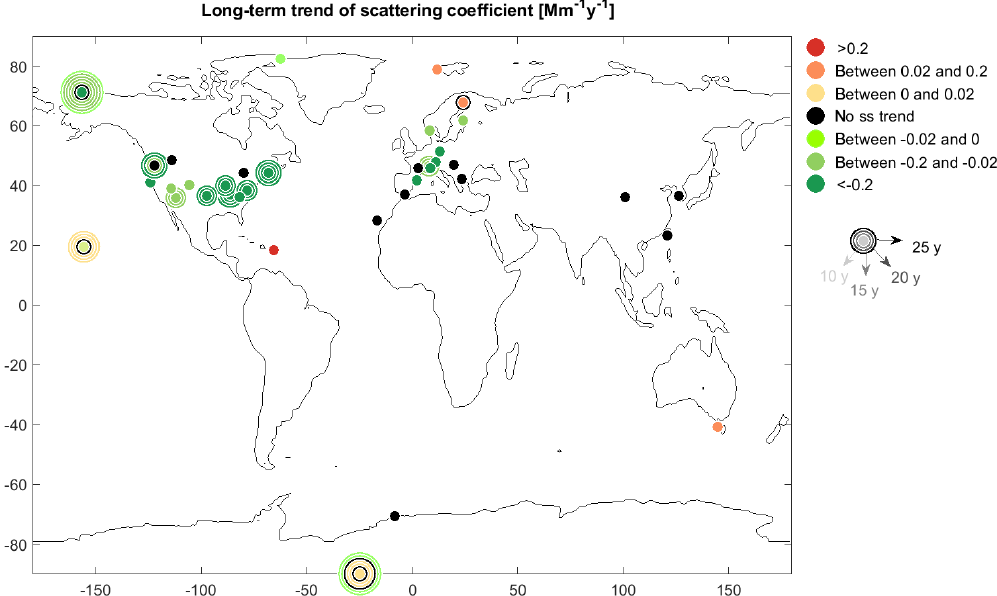
Figure 4. MK trend results for the scattering coefficient. Black symbols correspond to stations with no significant trends. Green and orange symbols correspond to ss negative and positive trends, respectively. The magnitude of the trends (slope) is given by the colors as stipulated in the legend. The size of the circles is proportional to the length of the datasets, with the central dots representing the most recent 10-year trend ending in 2016, 2017 or 2018. If possible, trends for longer time periods were calculated and the larger circles denote the trends for 15 to 40 years in 5-year